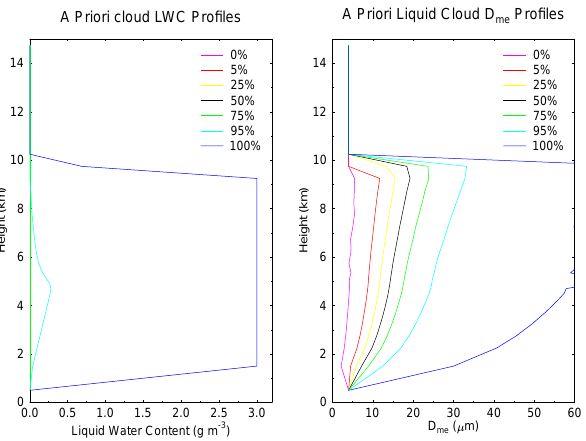
Fig. 5. Profiles of liquid cloud LWC and D me from seven per- centiles in the a priori cumulative distribution functions.